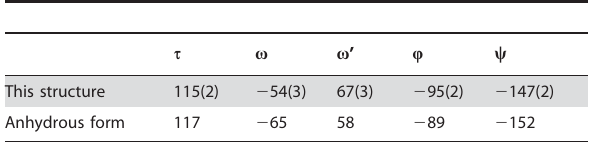
Table 2. Conformational parameters of anhydrous b -chitin and dihydrate from the X-ray